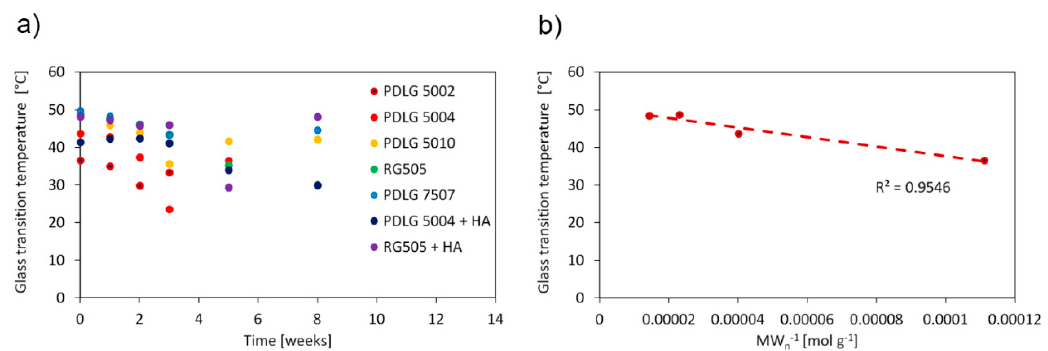
Figure 3. Glass transition temperature as a function of degradation time; values are expressed as the arithmetic average of three independent measurements ± standard deviation ( a ). Glass transition temperature as a function of MW n − 1 before degradation onset for PLGA 50 / 50 polymers ( b ). Dashed line represents the linear fit according to Flory–Fox equation.